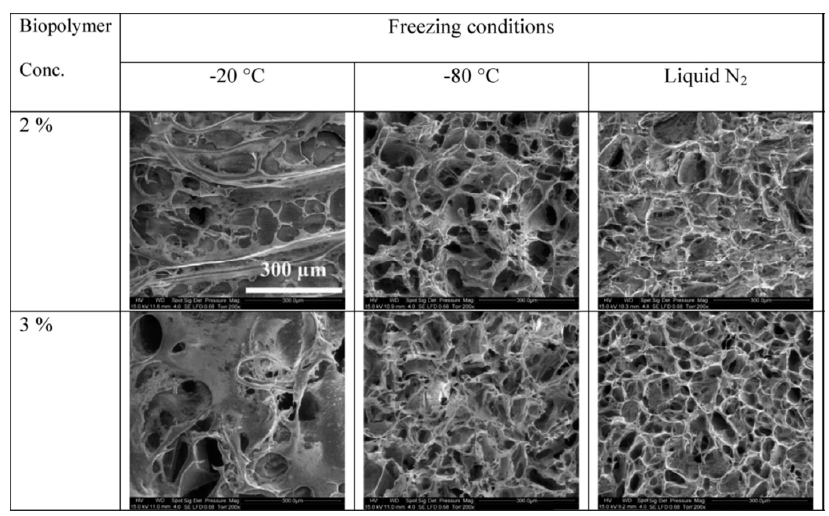
Figure 6. Textural properties of chitin sponges: effect of chitosan concentration and freezing temperature (reprinted with permission from Elsevier [153].